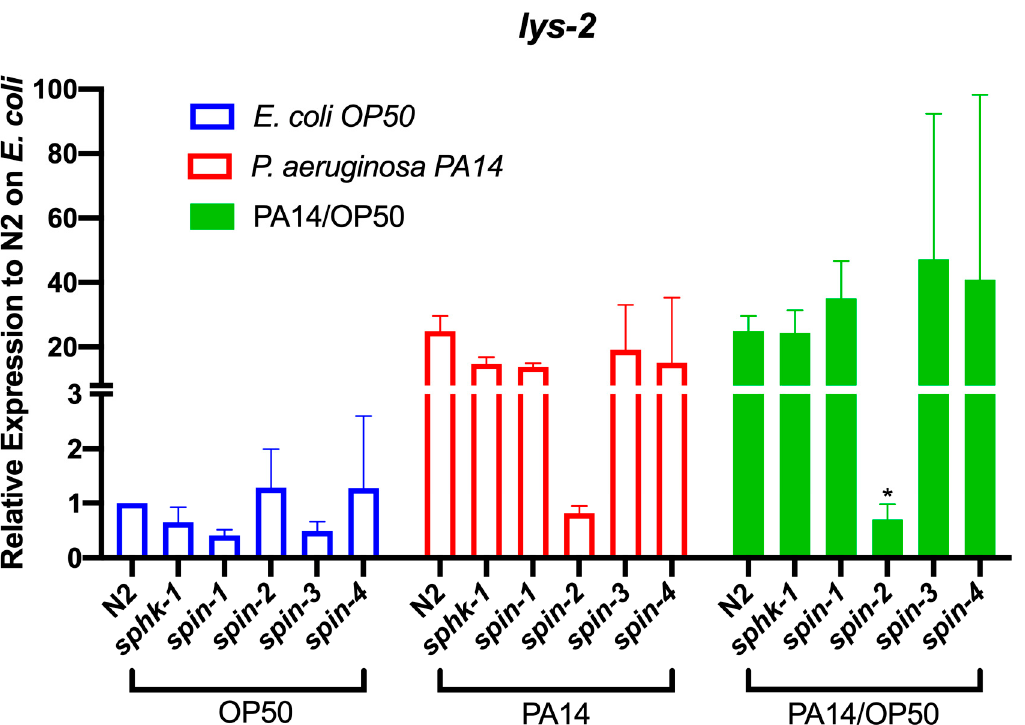
Figure 6. Transcriptional activation of immune response genes, lys-2 , was diminished in the spin-2 mutant worm. The fold changes of lys-2 in wild type, sphingosine kinase ( sphk-1 ) and S1P transporters mutant ( spin-1-4 ) worms were normalized to house-keeping gene, pmp-3 , and Y45F10D.4. The unpaired t-test was used for statistical analysis.